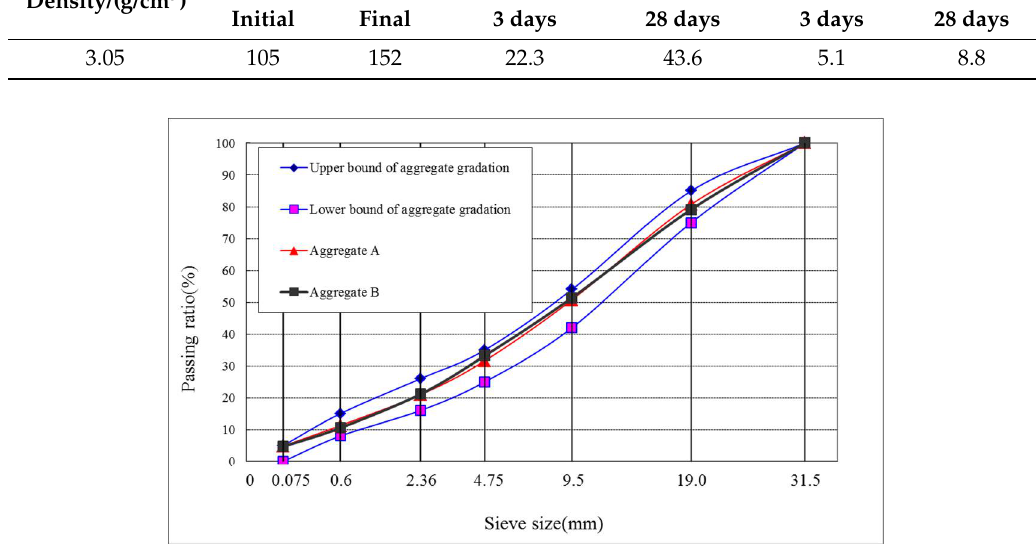
Figure 1. Aggregate gradation.